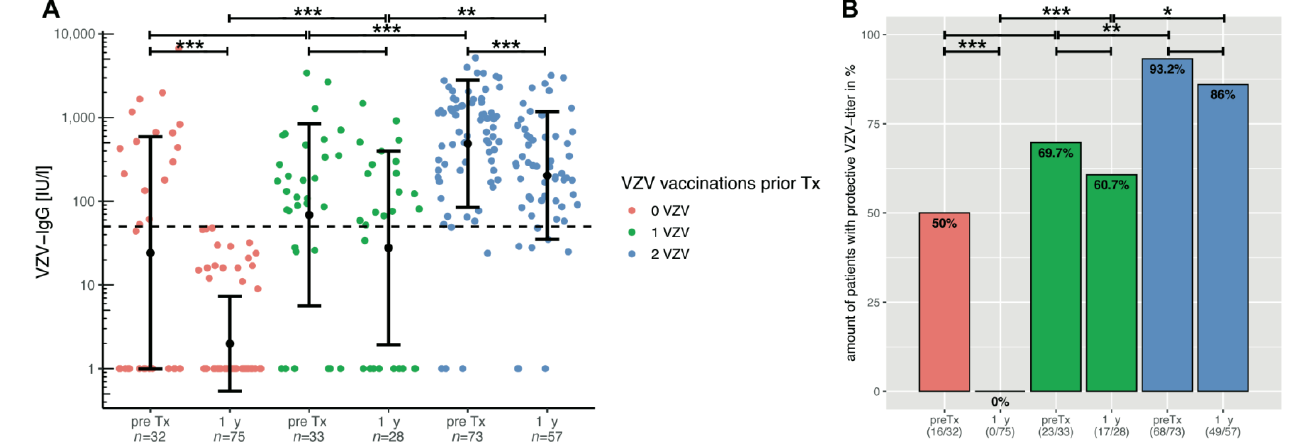
Figure 1. ( A ) VZV-specific antibodies before and 1 year after paediatric liver transplantation, de- pending on number of VZV vaccinations prior to transplantation. The y -axis is scaled logarithmi- cally. Data is shown as mean ± standard deviation. The dashed line marks the threshold for sero- logical protection. All groups show a decrease in mean titre after transplantation, regardless of the number of vaccine doses. However, as the bar plots in ( B ) show, patients with protective VZV an- tibodies after 1 vaccination are more than 60%, and after 2 vaccinations, more than 85% are still serologically protected. Significant data is marked as follows: * <0.05, ** <0.01, *** <0.001.